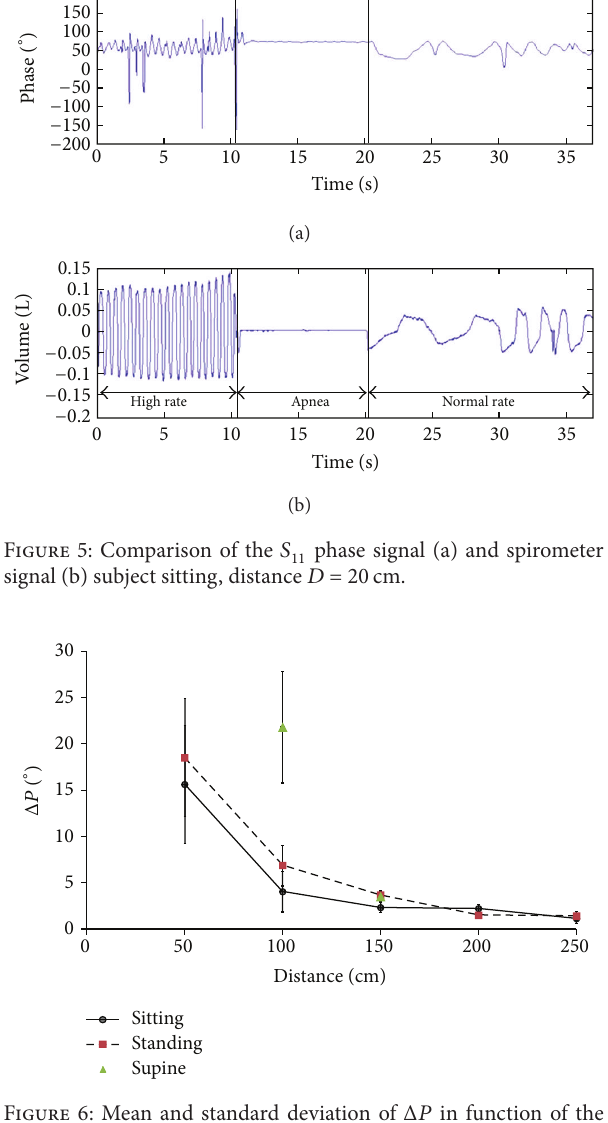
Figure 6: Mean and standard deviation of Δ𝑃 in function of the distance 𝐷 for sitting, standing, and lying